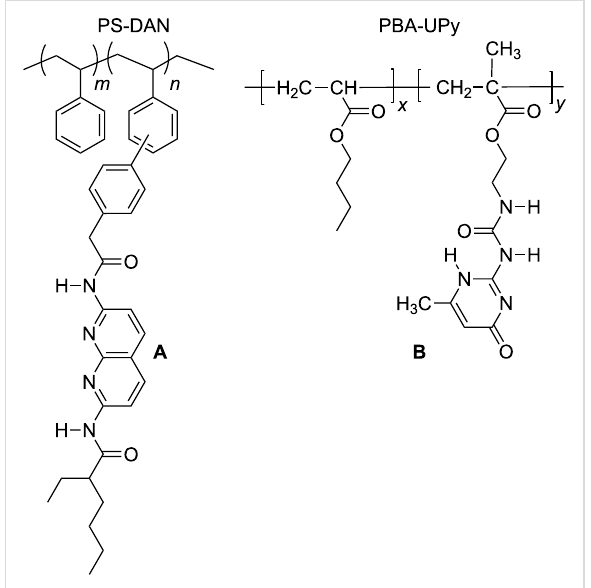
Figure 4: Structure of DAN-modified PS and Upy-modified PBA.